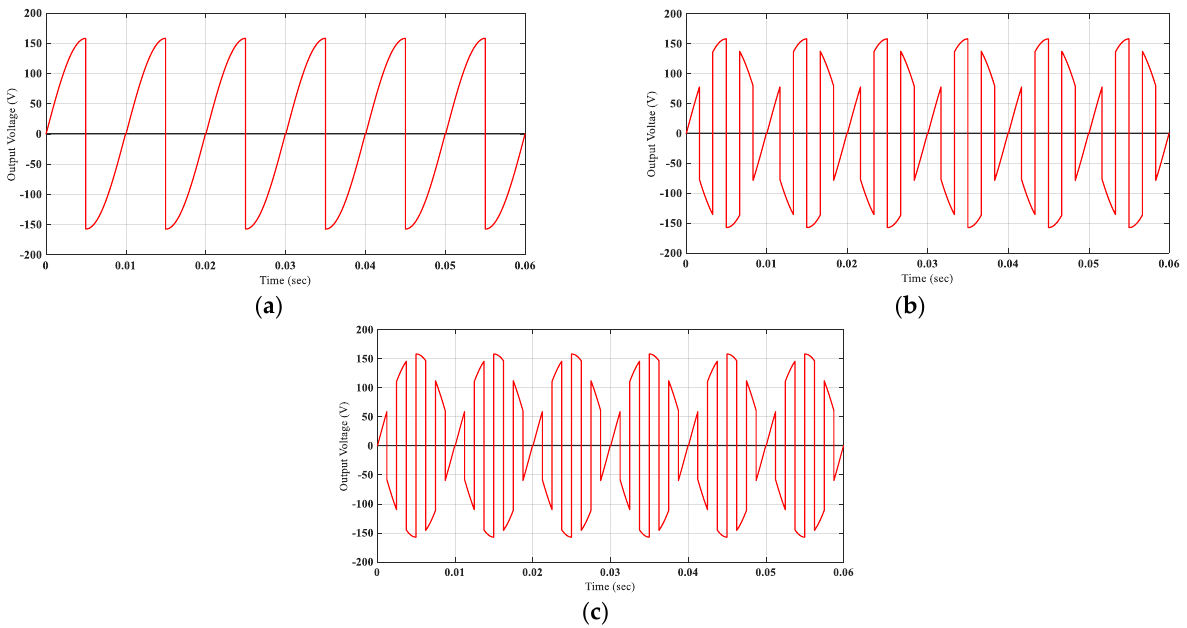
Figure 13. High frequency outputs with respect to constant input frequency (50 Hz): ( a ) 2(50) Hz; ( b ) 3(50) Hz; ( c ) 4(50) Hz.